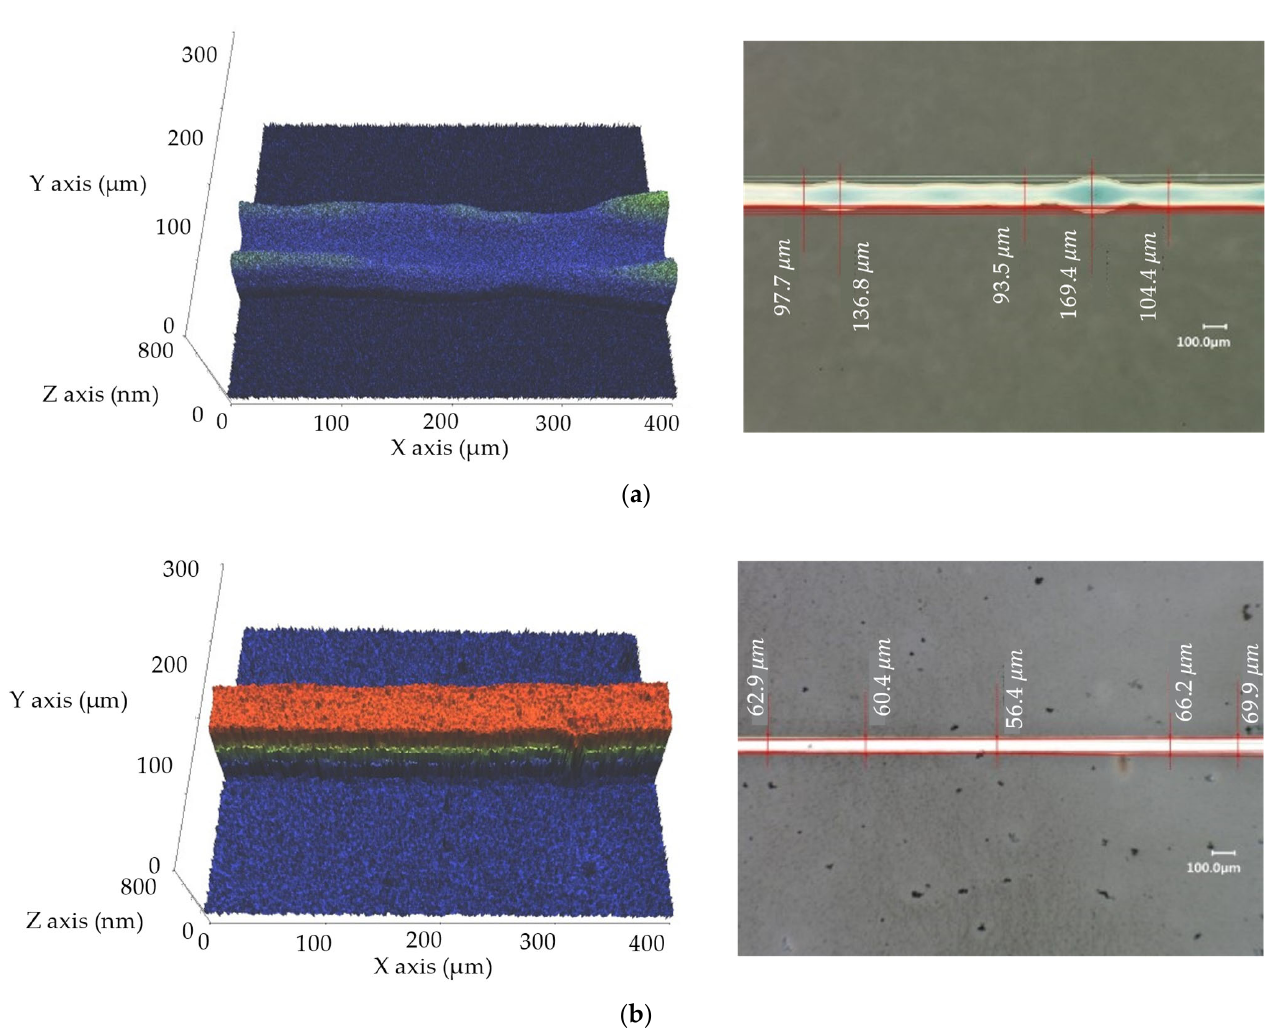
Figure 4. The 3D and 2D profiles of printed silver lines on ( a ) bare glass and ( b ) the surface with selective we tt ing technique: inkjet drop spacing is 5 µm for both cases and laser ablation width is 60 µm for case ( b ).